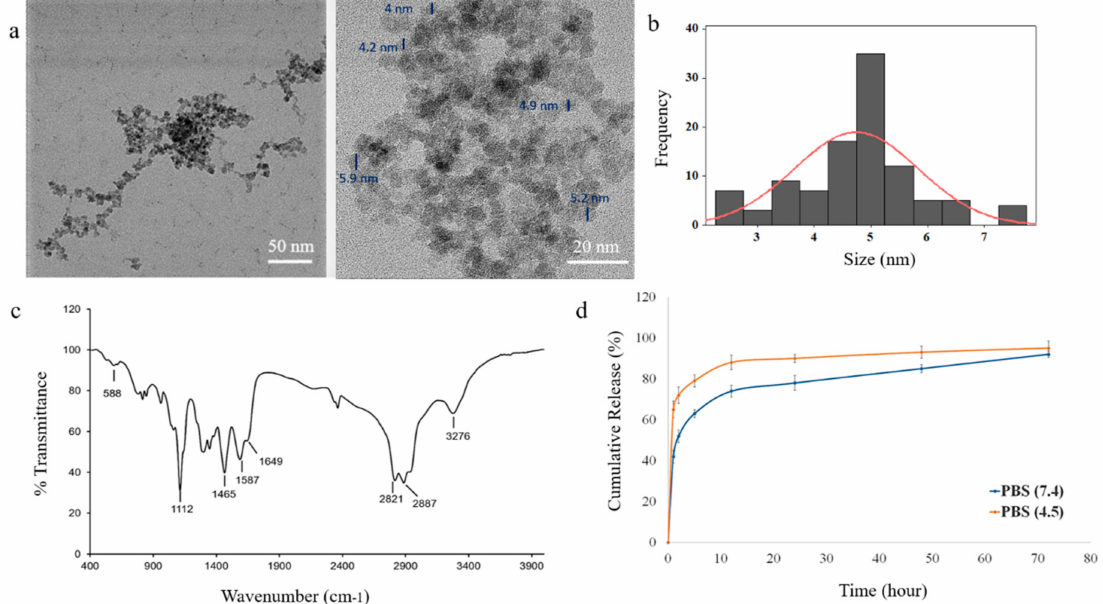
Figure 1. Characterization of polyethylenimine polyethylene glycol iron oxide nanoparticles (PEI-PEG-IONPs) and release of salinomycin from salinomycin-loaded (Sali)-PEI-PEG-IONPs: ( a ) transmission electron microscopy (TEM) images of PEI-PEG-IONPs, with core size measurement of the nanoparticles; ( b ) size distribution histogram; ( c ) Fourier transform infrared (FTIR) spectrum; ( d ) release of salinomycin from the nanoparticles in pH 7.4 (physiological pH) and pH 4.5 (pH of acidic intracellular compartments such as